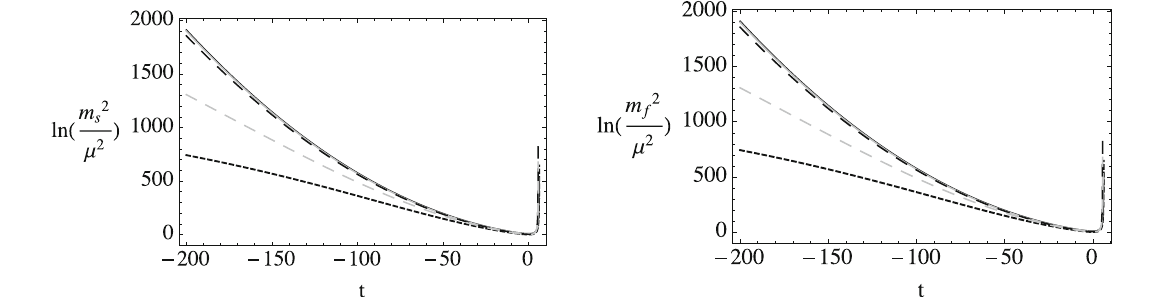
/μ 2 ) for the case (small dashed black line). In all cases it is seen that the flow has a min- f imum. If throughout the flow both m 2 s /μ 2 > 1 and m 2 both of them never go on-shell